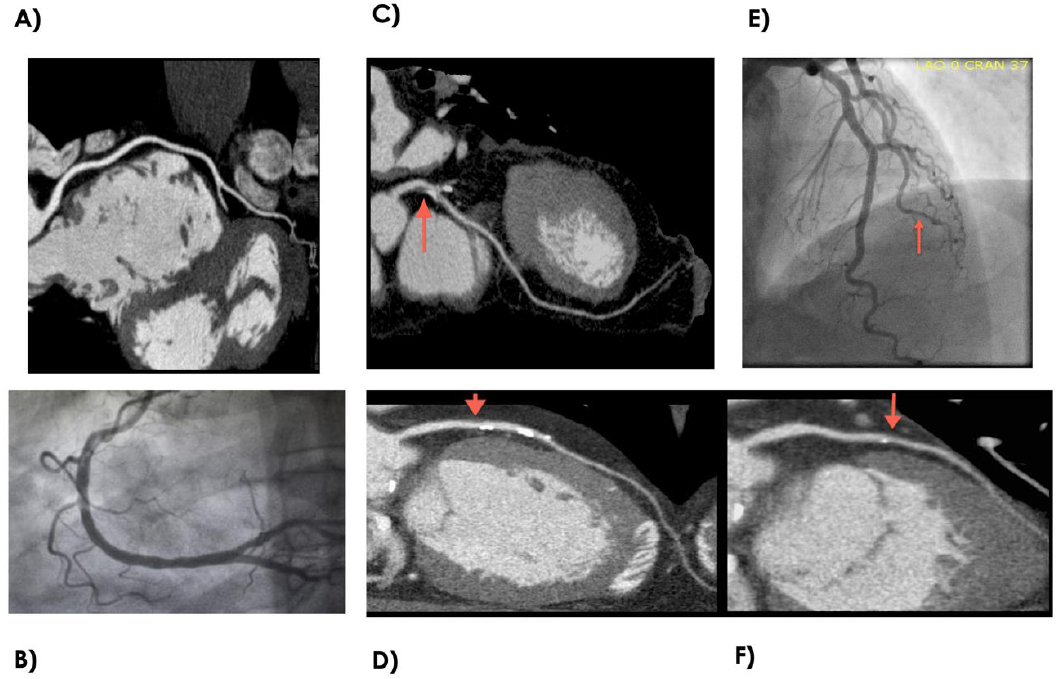
Figure 2. Example of normal and disease coronary anatomy as depicted by coronary CTA and coronary angiogram. ( A ) Normal right coronary artery by coronary CTA. ( B ) Normal right coronary artery by coronary angiogram. ( C ) Focal Mixed calcified atherosclerotic plaque in the proximal left anterior descending artery as depicted by coronary CTA. ( D ) Sequential soft lipid and calcified plaque in the mid-to-proximal left anterior decending artery as depicted by coronary CTA. ( E ) Luminal irregularities involving the 2nd diagonal branch as depicted by coronary angiogram. ( F ) Focal luminal remodeling with mix soft lipid plaque and spotty calcifications. CTA—Computed Tomography Angiography. Table 2. Clinical Characteristics of Patients with CAD and Healthy Controls.